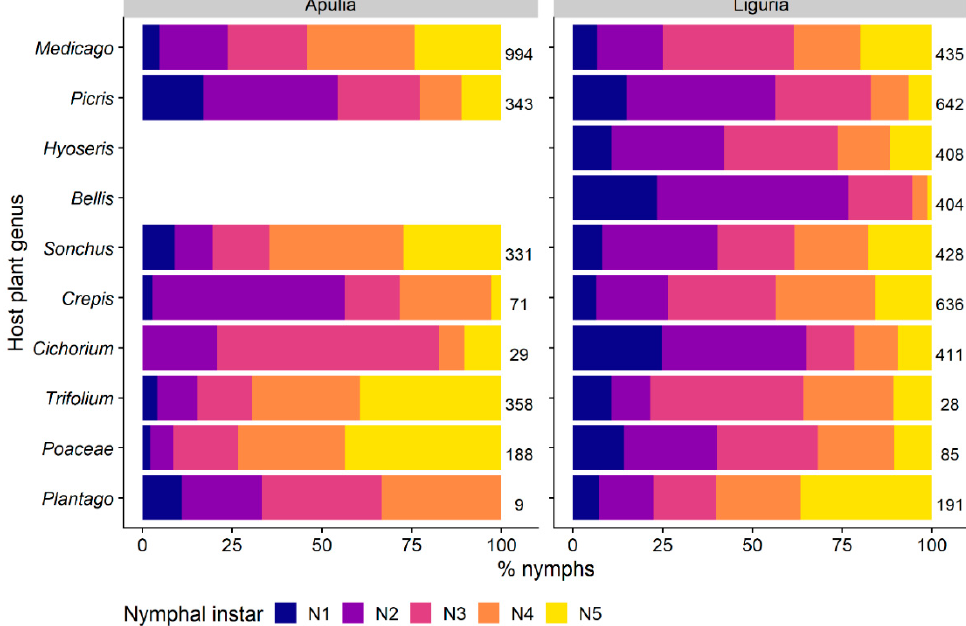
Figure 6. Relative percentage of the nymphal instars of Philaenus spumarius on the 10 most selected host-plant genera in Apulia and Liguria olive groves (i.e., plant genera hosting the highest number of spittlebug nymphs). Numbers beside bars represent the total number of nymphs sampled on each genus in each region.